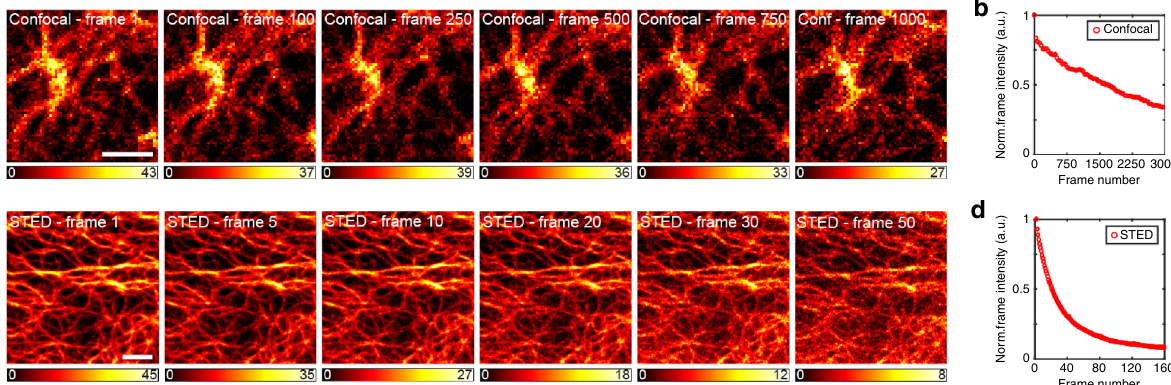
Fig. 5 Confocal and STED time-lapse imaging of vimentin-emiRFP703. a , b A confocal image series ( a ) and c , d a STED image series ( c ) of live HeLa cells transfected with emiRFP703-vimentin. The graphs ( b , d ) show the normalized integrated intensity of the recorded frames (red circles) for both image series, plotted every 40th frame for the confocal for better visualization ( b ) and every frame for STED ( d ). The displayed intensity scale has been adjusted per frame from zero to the maximum in respective frame. Scale bars, 2